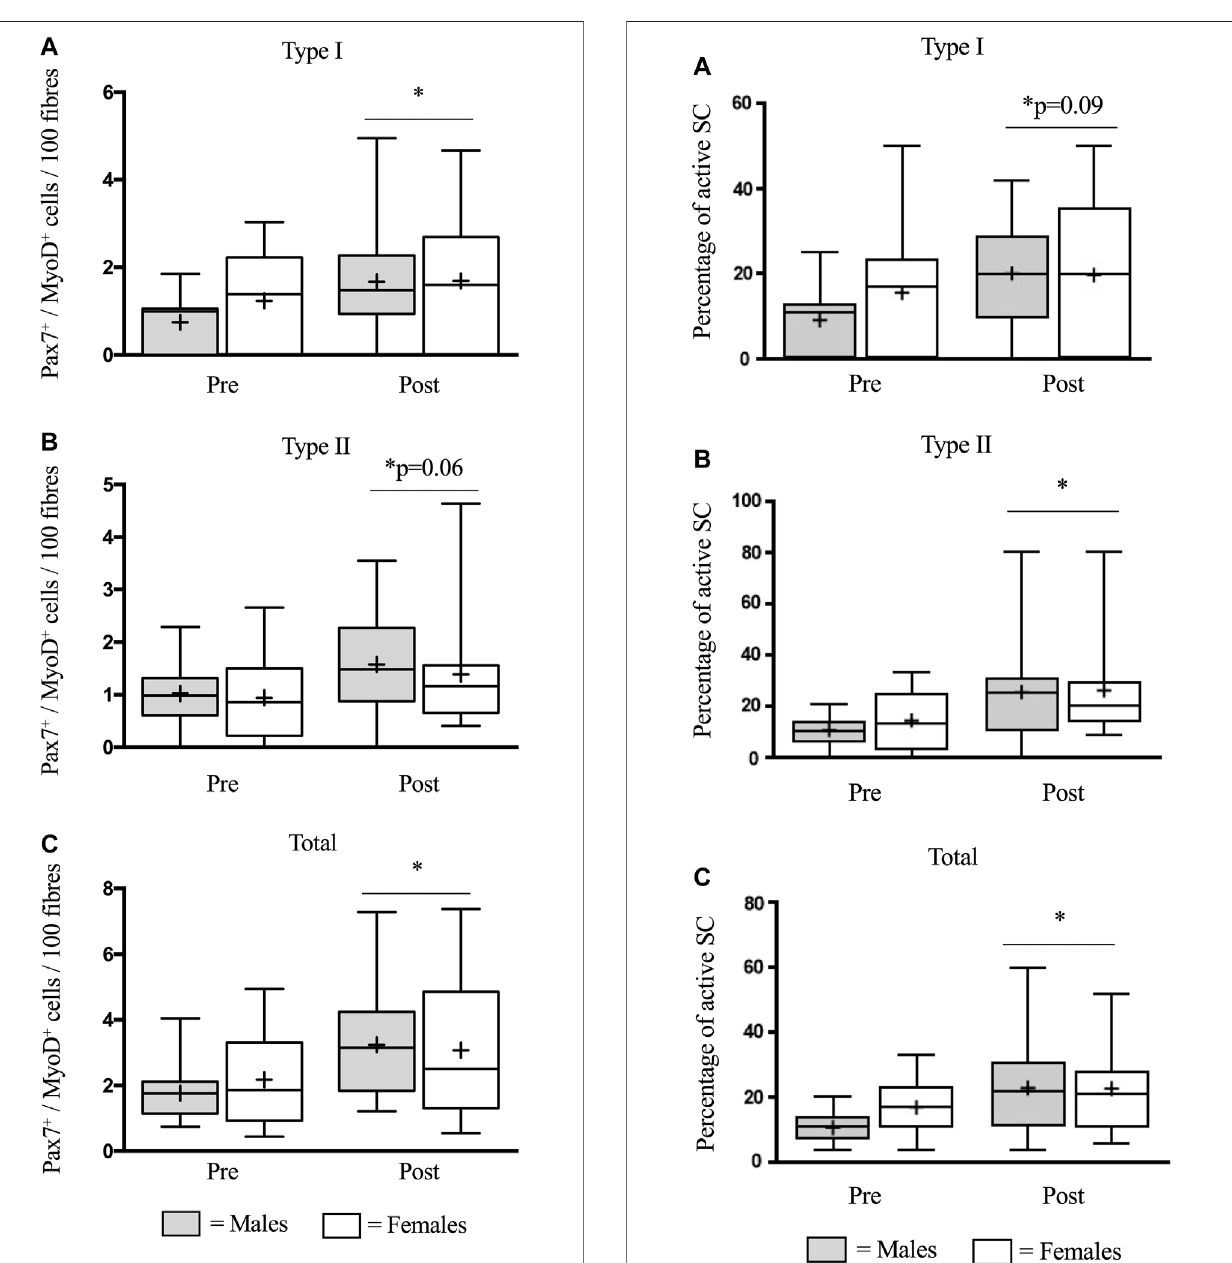
FIGURE 3 | Mean number of activated satellite cells (SCs) per muscle fi bre in type I (A) , type II (B) , and total (C) muscle fi bres before (pre) and 48 h (post) following eccentric damage. The box-and-whisker plot displays the median(line)andthemean(+),withtheboxrepresentingtheinterquartile range (IQR), and the whiskers representing the maximum and minimum values. * indicates a signi fi cant effect of time ( p < 0.05).